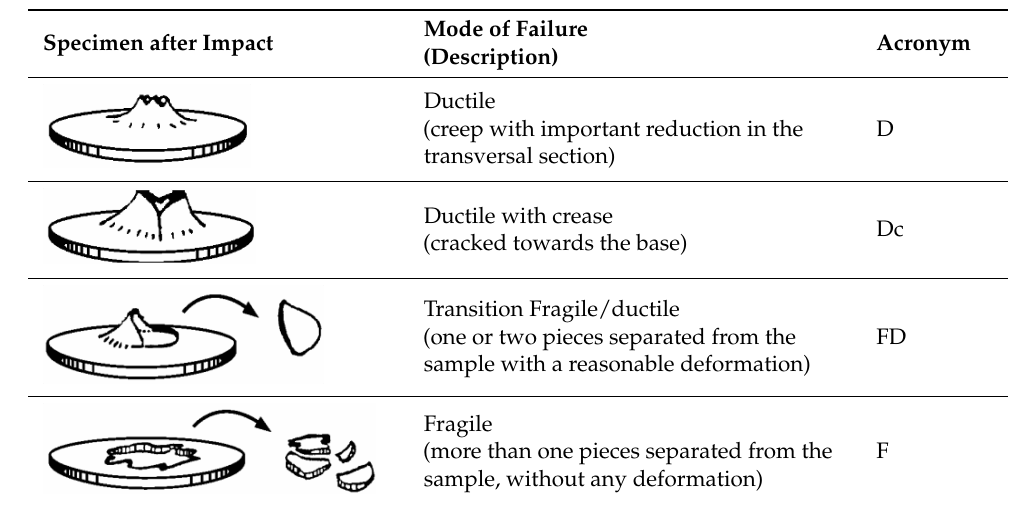
Table 1. Failure modes in the puncture impact test ISO 6603-2:2000